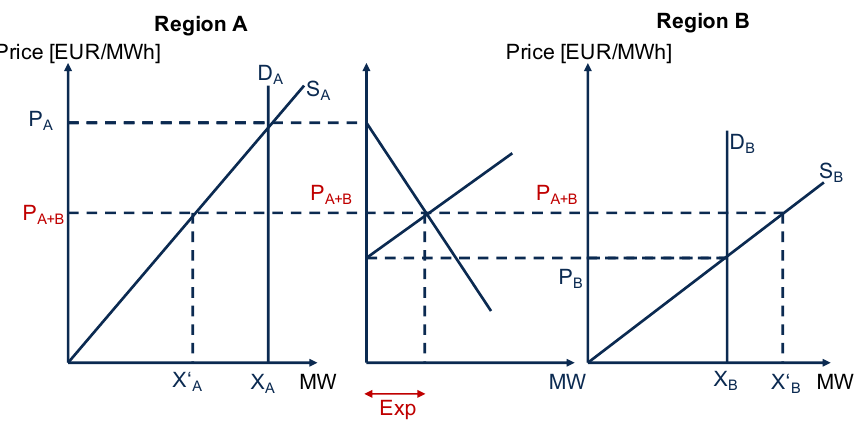
Figure 2. Graphical representation of cross-border exchange absent VRE, source: own